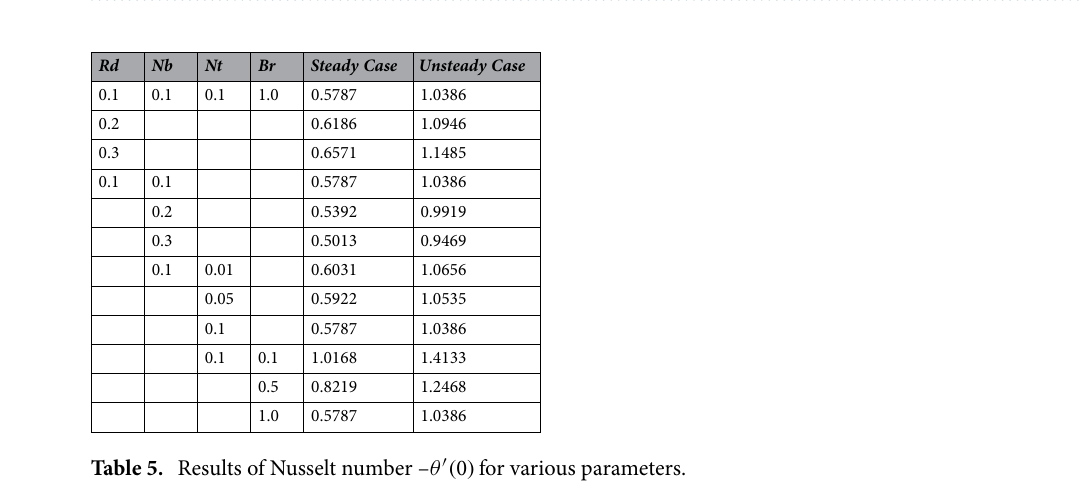
Table 4. Results of skin friction factor g ′ ( 0 ) in y-direction for various parameters.